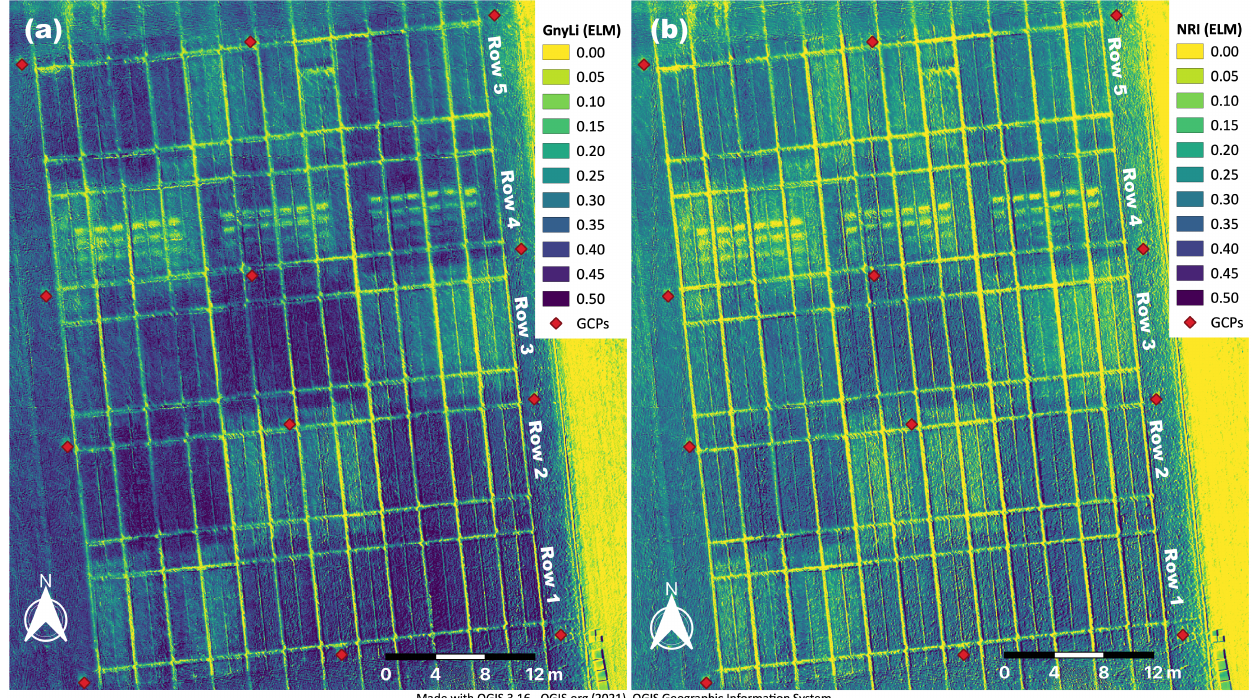
Figure 6. ( a ) GnyLi and ( b ) NRI orthomosaics processed from the four ELM-calibrated waveband orthomosaics (910, 980, 1100 and 1200nm) derived from the camera system’s spectral image